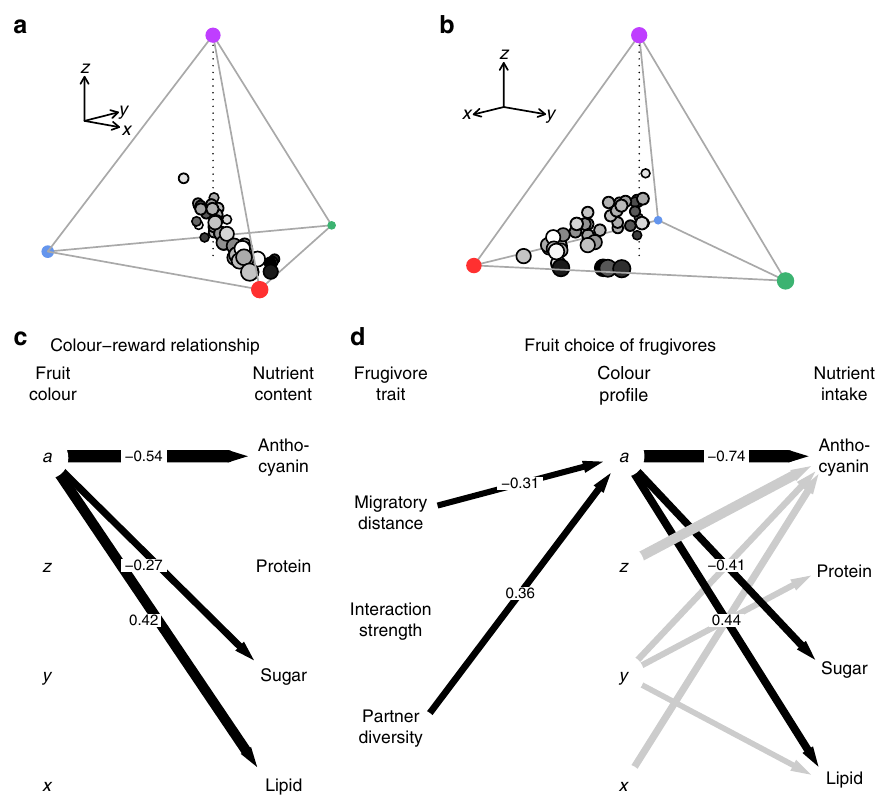
Fig. 2 Colour – reward relationships mediate fruit choice by frugivorous birds. a , b Fruit colours of the 44 plant species in the plant – frugivore networks according to the visual perception of birds in tetrahedral colour space 37,38 from two different perspectives (see Methods). The avian colour space within the tetrahedron is characterized by three Cartesian coordinates ( x , y , z ) that are related to particular chromatic colour components. The x -coordinates range from blue (negative scores) to red (positive scores), y -coordinates range from purple (negative scores) to green (positive scores), whereas z - coordinates indicate UV re fl ectance (positive scores). The achromatic component (fruit brightness, a ) indicates whether a fruit is perceived as being bright (high values) or dark (low values). In a , b fruit brightness is indicated by the grey colour of the circles, ranging from white (bright fruits) to black (dark fruits). c Most parsimonious Bayesian hierarchical model showing the relationships between chromatic colour components of fruit colours ( x , y , z ), fruit brightness ( a ) and the nutrient concentrations in fruit pulp (lipid, sugar, protein, and anthocyanin). The sample size in c was n species = 44 plant species. d Most parsimonious Bayesian hierarchical structural equation model of fruit choice by frugivores showing the relationships of the birds ’ partner diversity and interaction strength in the networks and their migratory behaviour with the colour pro fi le of consumed fruits and the mean intake of particular nutrients. The sample size in d was n obs = 165 observations across n species = 43 bird species, n site = 3 study sites and n time = 4 seasons. In c , d relationships that received positive support during the variable selection (BF > 2) are highlighted in black. See caption of Table 1 for interpretation of BF-values. The numbers on the arrows indicate the effect size and direction of the relationships. In d relationships between colour pro fi les of consumed fruits and the nutrient intake of birds that were supported by the variable selection but were not related to frugivore traits are drawn in